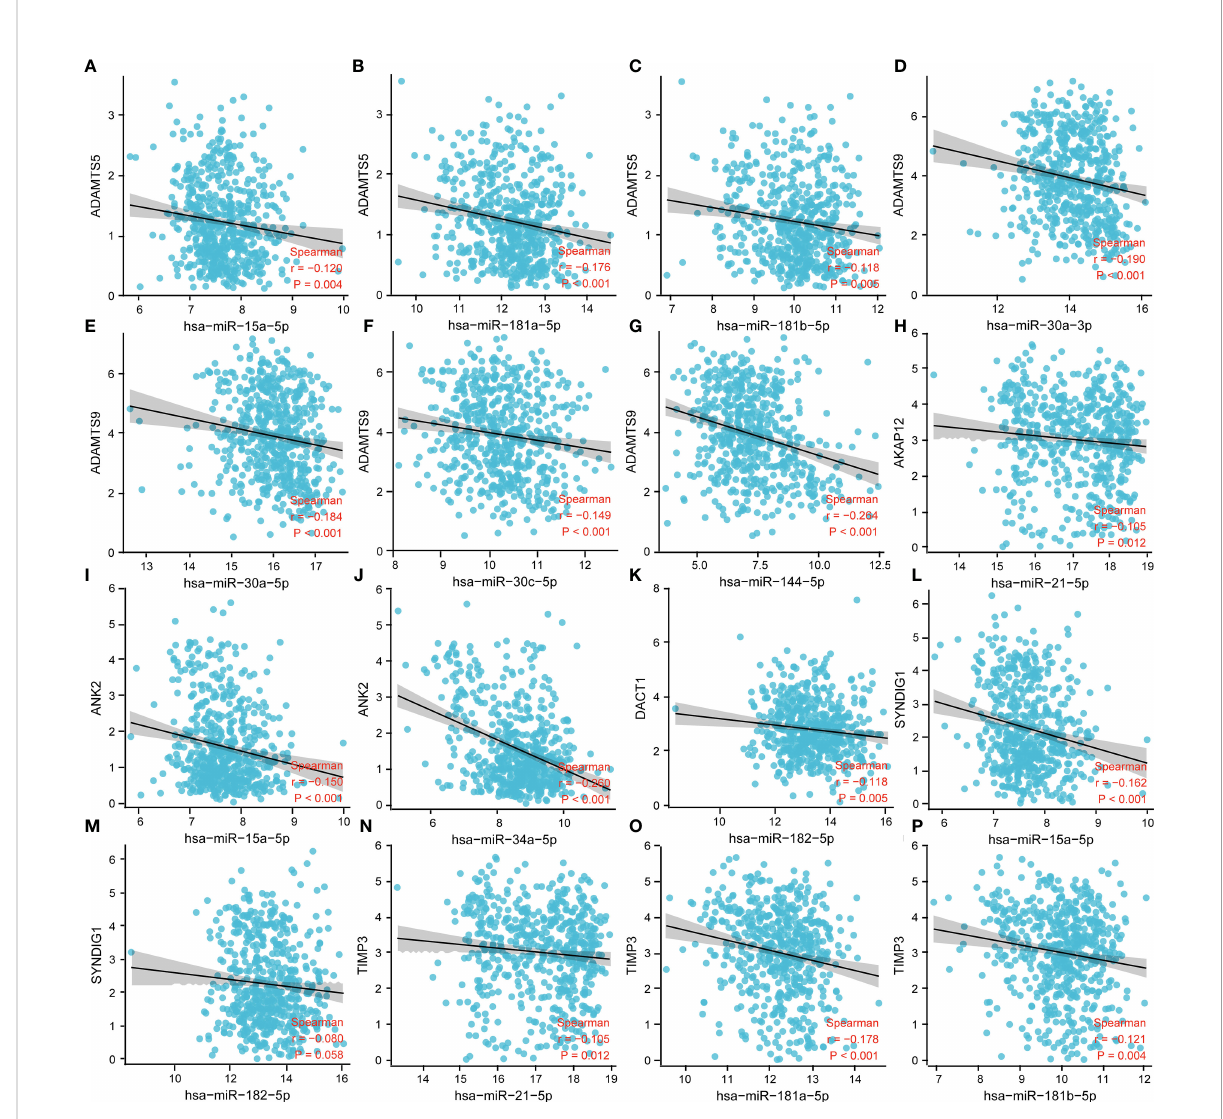
FIGURE 6 Correlation analysis between miRNA and prognostic immune factors. (A – C) ADMTS5 with miR-15a-5p, miR-101-3p, miR-181a-5p, miR-181b-5p; (D – G) ADMTS 9 with miR-30a-5p, miR-30a-3p, miR-30c-5p, miR-144-5p; (H) AKAP12 with miR-21-5p. (I, J) ANK2 with miR-15a-5p, miR-34a- 5p; (K) DACT1 with miR-182-5p; (L, M) SYNDIG1 with miR-15a-5p, miR-182-5p; and (N – P) TIMP3 with miR-21-5p, miR-181a-5p, and miR-181b- 5p. P < 0.05 was statistically signi fi